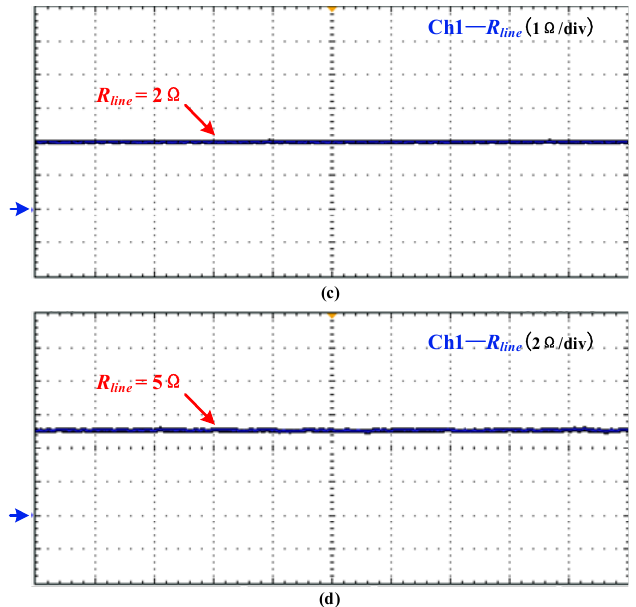
Figure 11. Estimation results of different resistances ( x -axis: time, 1 s/div; y -axis: magnitude of the measured signal): ( a ) R line = 0.1 Ω ; ( b ) R line = 0.5 Ω ; ( c ) R line = 2 Ω ; ( d ) R line = 5 Ω .